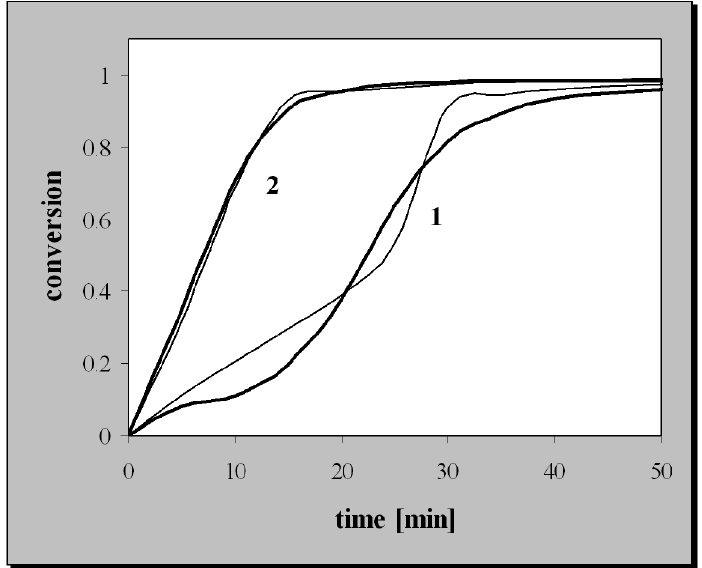
Fig. 15 Variation of monomer conversion with time for: (1) T = 90 o C and I 0 = 10 mol/m 3 ; (2) T = 90 o C and I 0 = 100 mol/m 3 ; thick lines - predictions on MLP (3:9:3:3), thin lines - kinetic model [18],